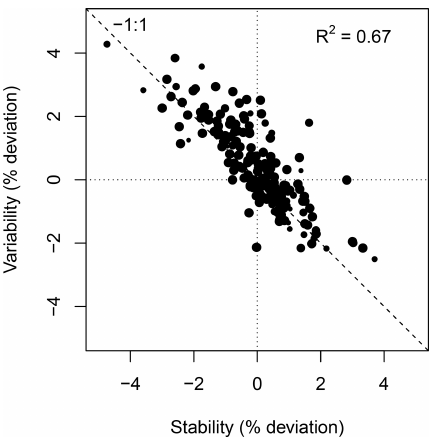
Figure 11. Variability and stability (relative bias) of weekly median TGS 2600 sensor 1-derived CH 4 mole fractions are inversely related and plotted along the − 1 : 1 line. Symbol size is proportional to relative data coverage.